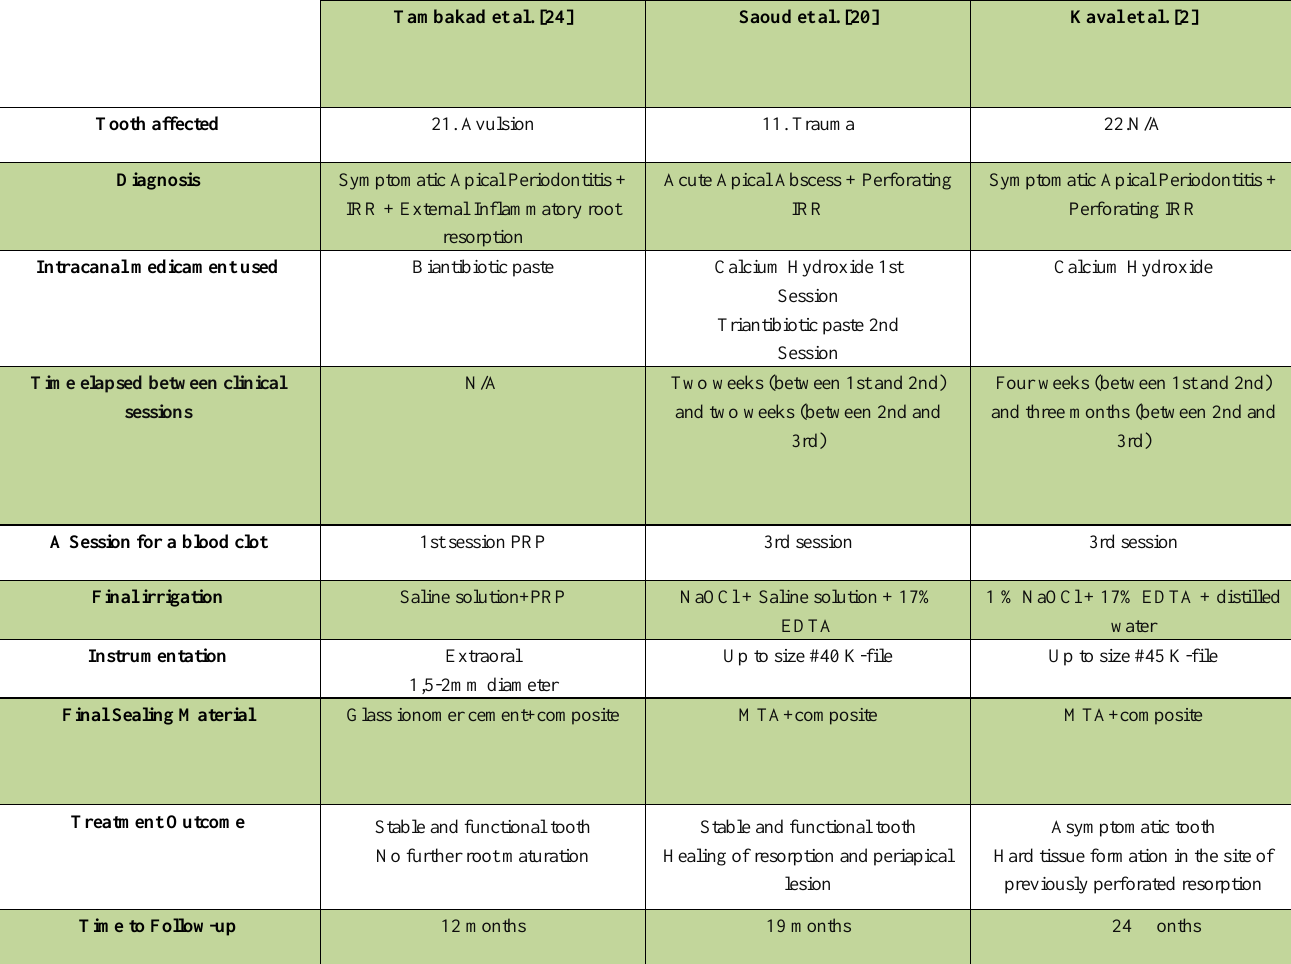
Table 1. Summary of the most relevant data published in the available